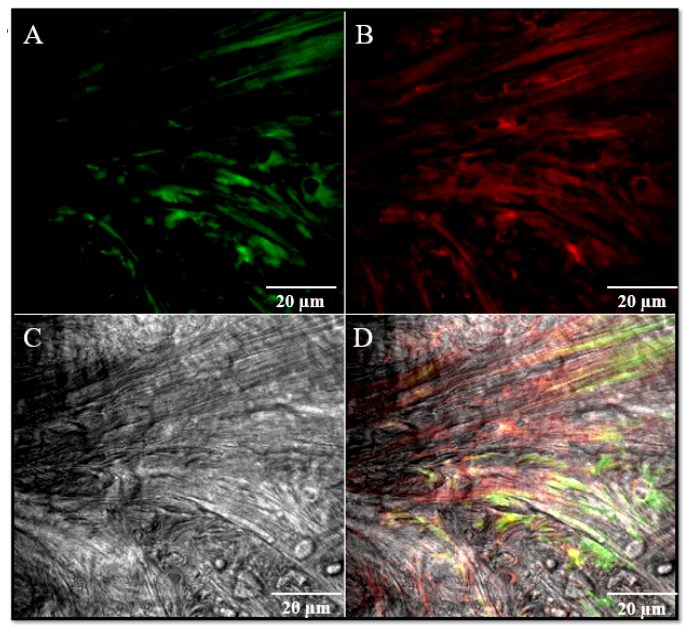
Figure 4. Double localization immunofluorescence reaction performed on discal lateral ligament using antibody against Collagen I ( A ), green channel and Elastin ( B ), red channel. Pictures show an intense fluorescence pattern for both proteins ( A , B ). ( C ) transmitted light (TL); ( D ) the yellow fluorescence depends on the merge of green and red channels. Magnification: 40x.